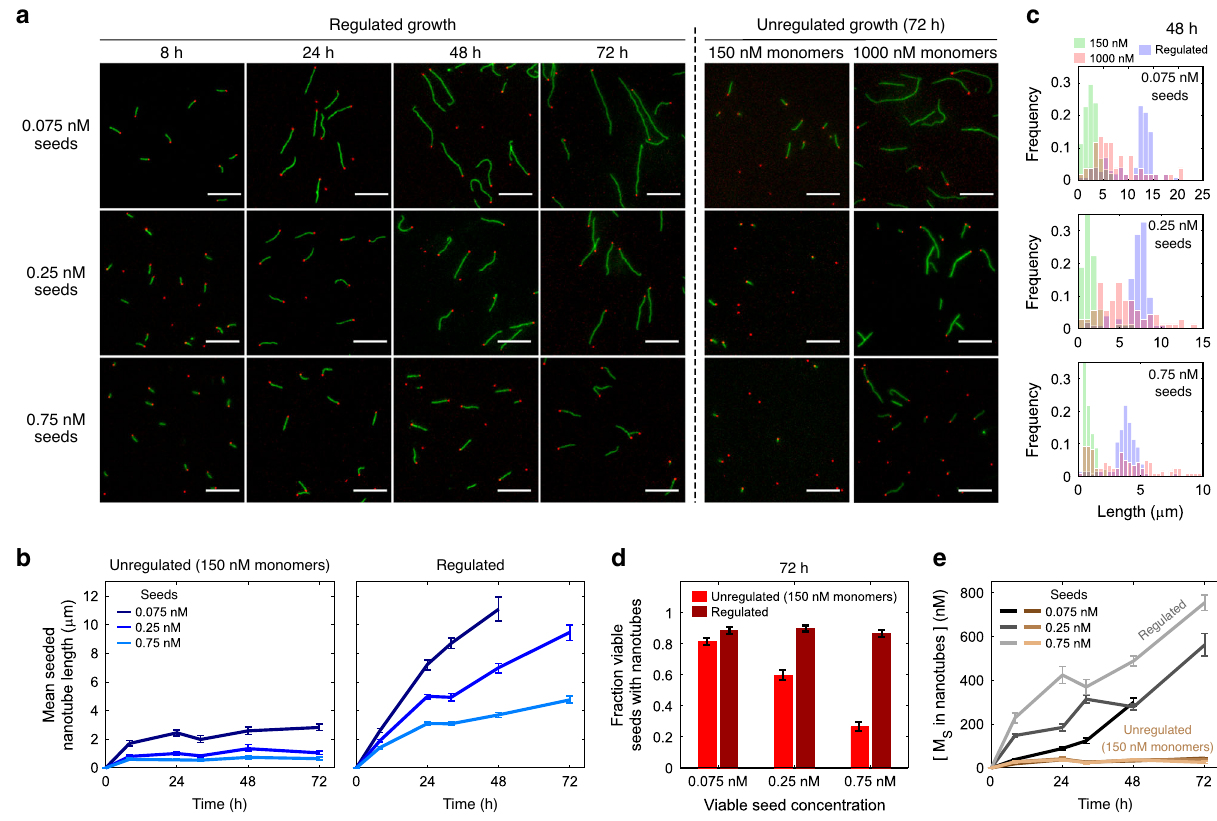
Fig. 5 Comparing unregulated DNA nanotube growth with buffer-regulated growth. a Fluorescence micrographs of DNA nanotubes after different durations of unregulated or buffer-regulated growth. Scale bars: 10 µ m. b Mean lengths of seeded nanotubes during unregulated (left) or buffer-regulated growth (right) (Methods, Supplementary Fig. 18). Error bars represent 95% con fi dence intervals from bootstrapping. c Distributions of seeded nanotube lengths after 48 h from the experiments presented in a . For distributions of nanotube lengths at other timepoints, see Supplementary Fig. 19. d Fractions of viable seeds with nanotubes after 72 h of growth. Experimental variation (possibly due to pipetting) and sampling errors introduced slight variations in the fractions of viable seeds with nanotubes across timepoints; at most timepoints regulated growth resulted in a fraction near 1. The fractions for all timepoints are shown in Supplementary Fig. 10. Error bars on proportions represent 95% con fi dence intervals. e Mean concentrations of M S incorporated into nanotubes during growth. This value is roughly 35 – 40 nM for unregulated growth at all seed concentrations. Error bars represent standard deviation across images. Regulated growth experiments were conducted with [ I i ] o = [ P i ] o = 5.5 µ M and [ C i ] o = 1.25 µ M for both monomer types. The sample sizes for every timepoint of each sample are tabulated in Supplementary Note